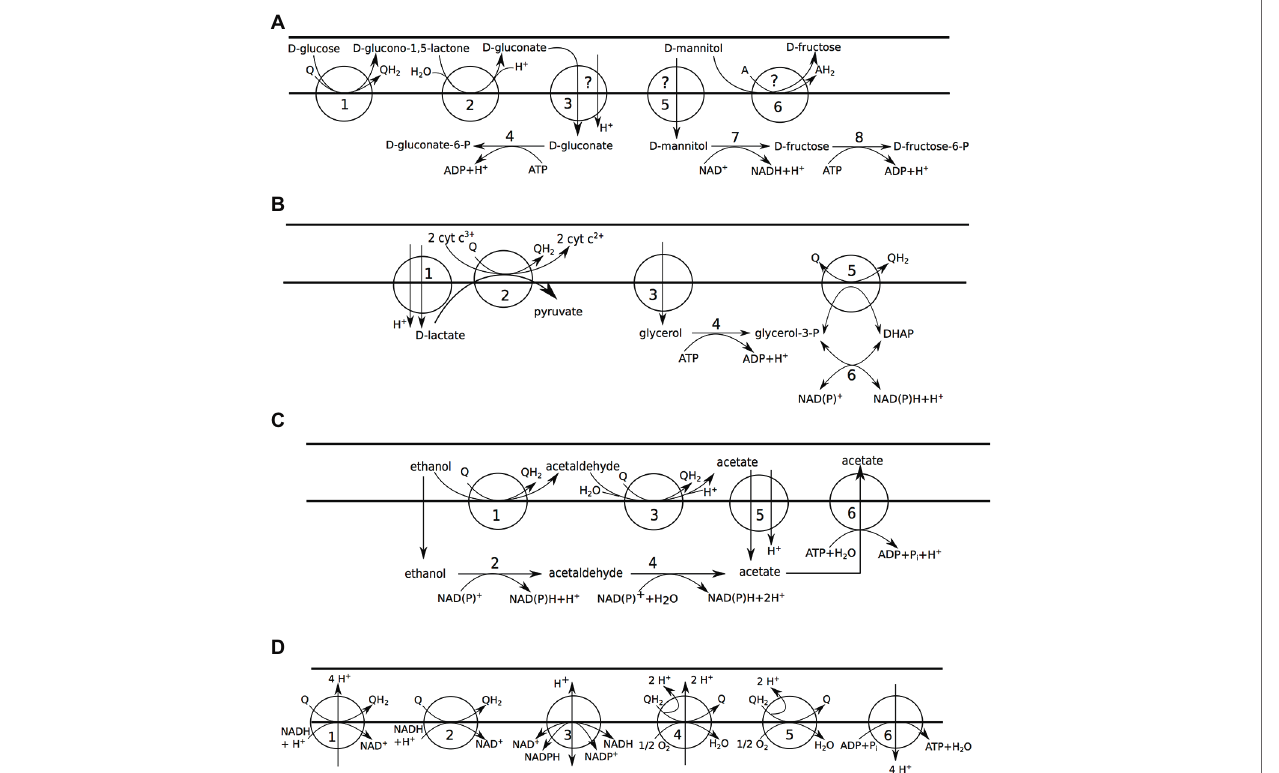
FIGURE 2 | Carbon metabolism of A. pasteurianus 386B. Horizontal bars (from top to bottom) delineate the extracellular environment, the periplasm, and the cytosol, respectively. (A) Carbohydrate oxidation. (1) D-glucose:ubiquinone oxidoreductase (EC 1.1.5.2); (2) gluconolactonase (EC 3.1.1.17); (3) gluconate:H + symport; (4) gluconokinase (EC 2.7.1.12); (5) mannitol permease; (6) D-sorbitol dehydrogenase (mann_ox_rxn); (7) mannitol 2-dehydrogenase (EC 1.1.1.67); (8) fructokinase (EC 2.7.1.4). (B) Lactate and glycerol oxidation. (1) lactate:H + symporter; (2) D-lactate dehydrogenase (quinone) (EC 1.1.5.12), D-lactate dehydrogenase (cytochrome) (EC 1.1.2.4); (3) glycerol facilitator; (4) glycerol kinase (EC 2.7.1.30); (5) glycerol-3-phosphate dehydrogenase (EC 1.1.5.3); (6) glycerol- 3-phosphate dehydrogenase [NAD(P) + ] (EC 1.1.1.94). (C) Ethanol oxidation. (1) alcohol dehydrogenase (quinone) (EC 1.1.5.5); (2) alcohol dehydrogenase [NAD(P) + ] (EC 1.1.1.1, 1.1.1.2); (3) aldehyde dehydrogenase (quinone) (EC 1.2.5.2); (4) aldehyde dehydrogenase [NAD(P) + ] (EC 1.2.1.3, EC 1.2.1.4); (5) succinate-acetate:H + symporter; (6) acetate ABC transporter. (D) Aerobic respiration. (1) NADH:ubiquinone reductase (H + -translocating) (EC 7.1.1.2); (2) NADH:ubiquinone reductase (non-electrogenic) (EC 1.6.5.9); (3) proton-translocating NAD(P) + transhydrogenase (EC 7.1.1.1); (4) ubiquinol oxidase (H + -transporting) (EC 7.1.1.3); (5) ubiquinol oxidase (electrogenic, non-H + -transporting) (EC 7.1.1.7); (6) H + -transporting two-sector ATPase (EC